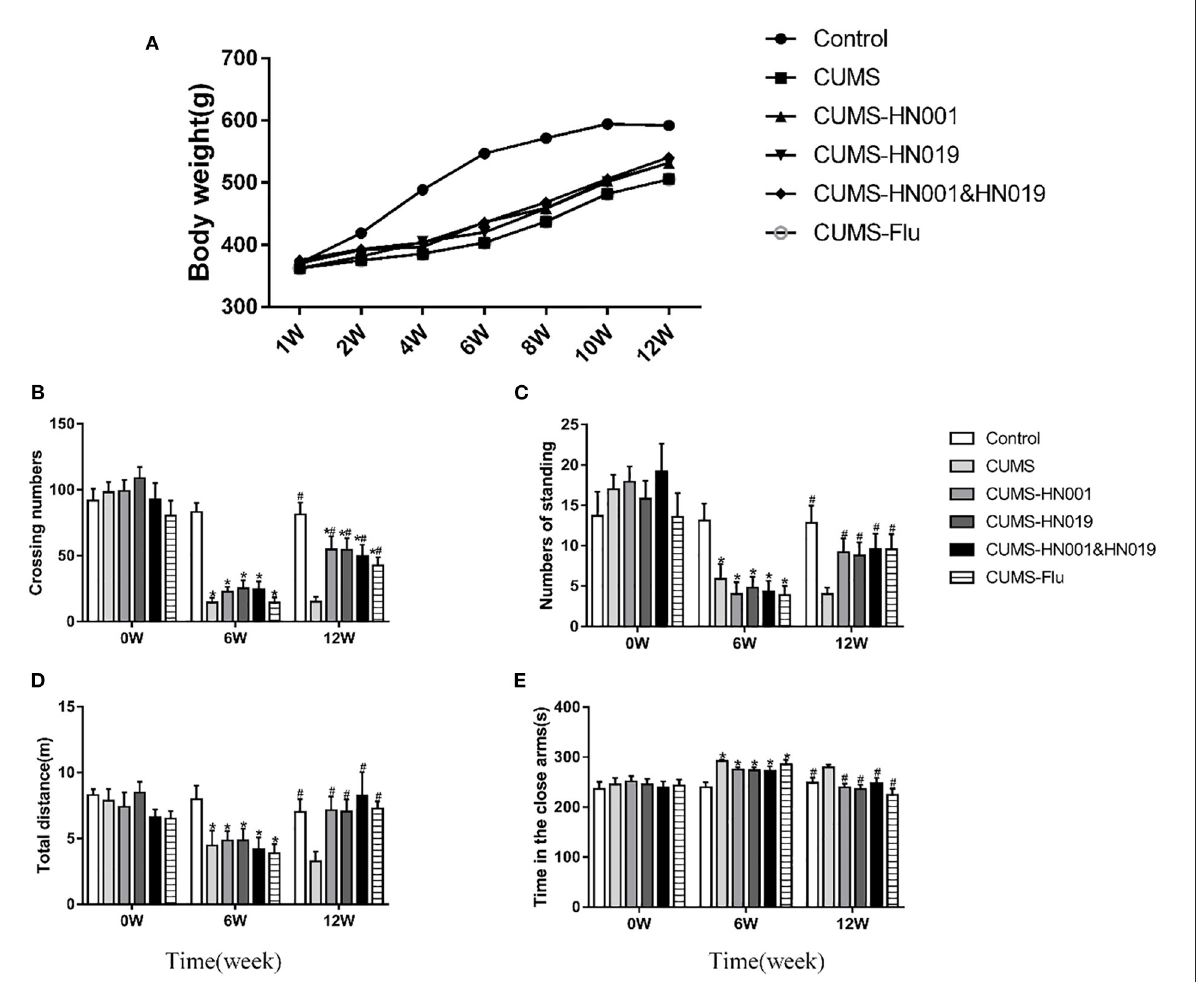
FIGURE2 Body weight and depression-like behavior of CUMS rats in different groups during the experiment. (A) Changes of body weight of rat under CUMS. (B) Crossing numbers in open-field test during baseline, 6th and 12th weeks. (C) Numbers of standing in open-field test during baseline, 6th and 12th weeks. (D) Total distance in elevated-plus during baseline, 6th and 12th weeks. (E) Time in the close arms in elevated-plus during baseline, 6 and 12th weeks. Data are expressed as Mean ± SEM ( n = 9–10). * p < 0.05 compared with control group. # p < 0.05 compared with CUMS